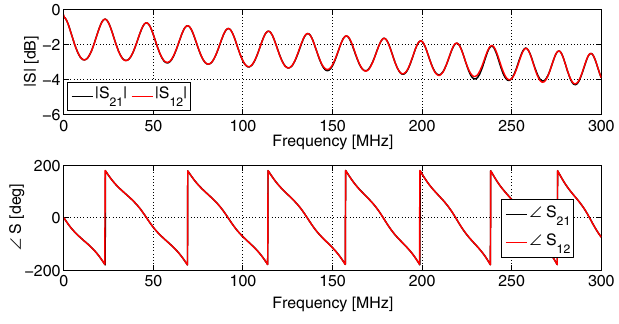
FIG. 17. Phases of the S ml parameters.